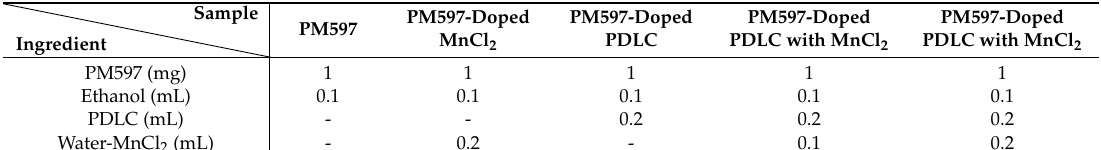
Table 1. The ingredients of samples in five systems.